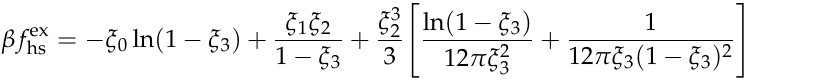
The first term on the right side of Equation (8), f ex , represents the contribution from the hs hard-core excluded volume interactions (see Equation (3)) of an ensemble of “disconnected” (assumed) hard spheres. This contribution is described by the BMCSL excess free energy density